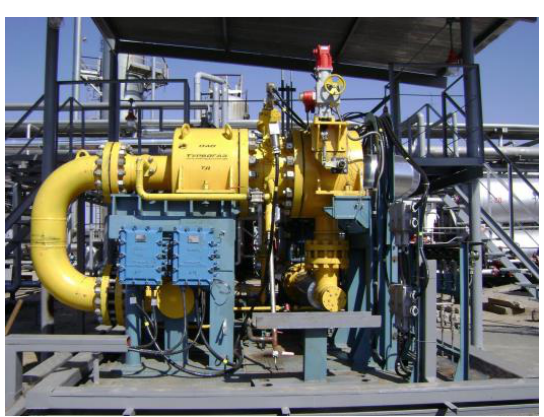
Figure 8. Operating characteristics of the flow part